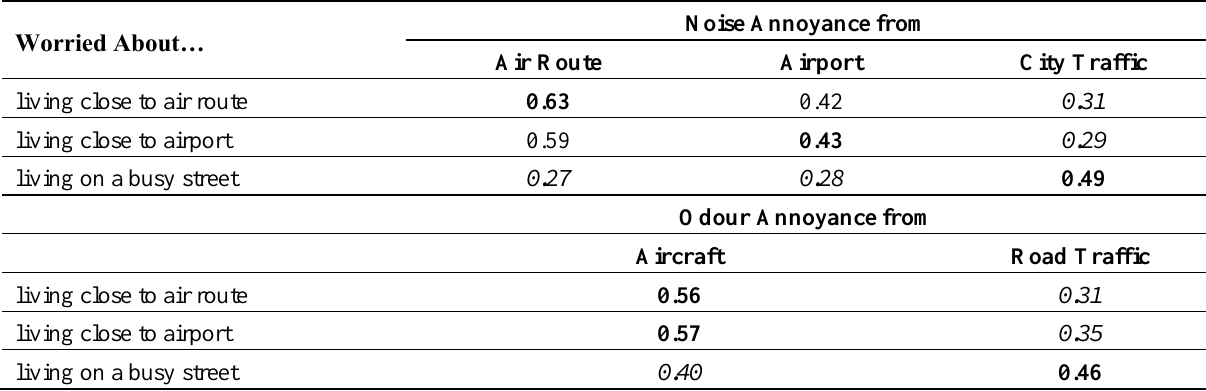
Table 2. Pearson’s correlation coefficients between individual scores for worry with respect to a situation and scores for annoyance from noise or odour from related (bold) and unrelated (italics) sources. All coefficients are significant at p <